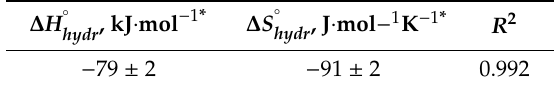
Table A1. Fitted parameters of Equation